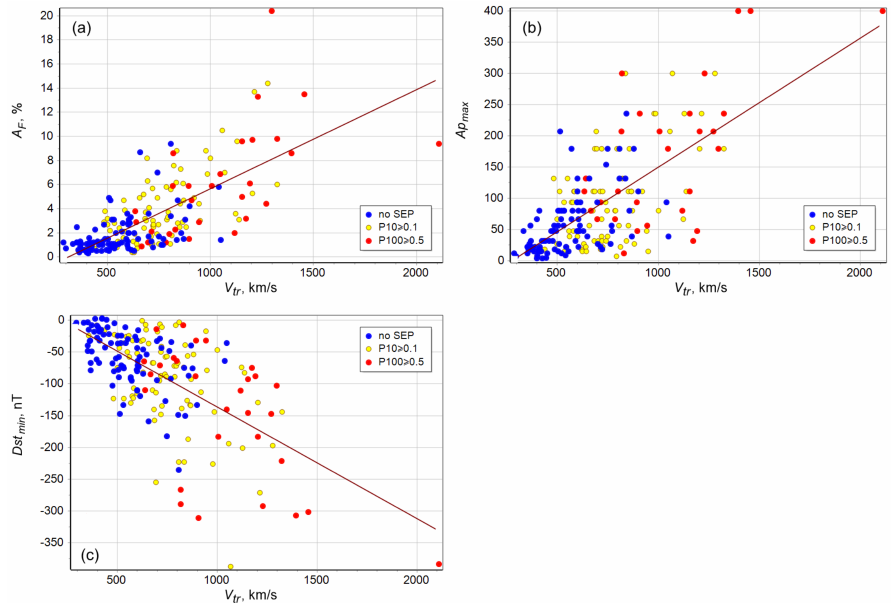
Figure 9. Relationship between ( a ) FD amplitude ( A F ); ( b ) maximum value of Ap -index; and ( c ) minimum value of Dst -index and the transit speed ( V tr ) of the corresponding